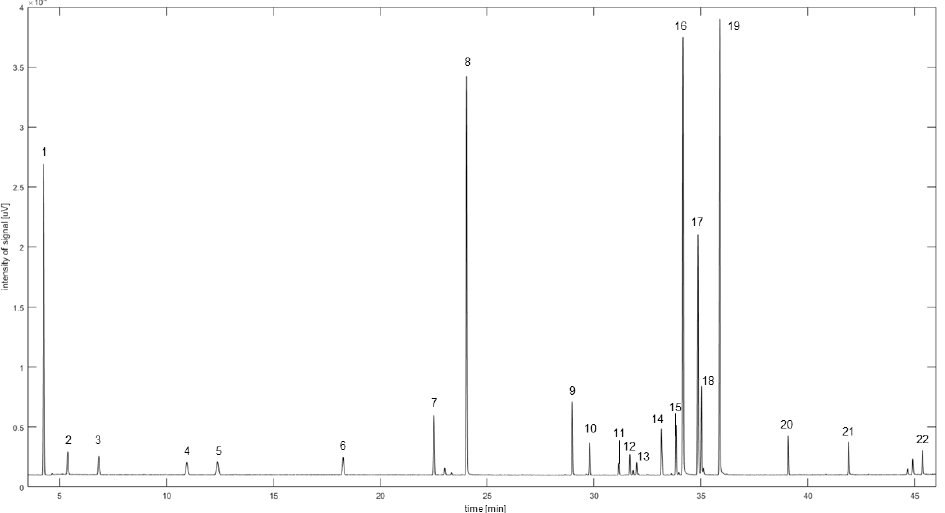
Figure 1. Chromatogram for the analysis of 22 rose oil components on DB-wax column.